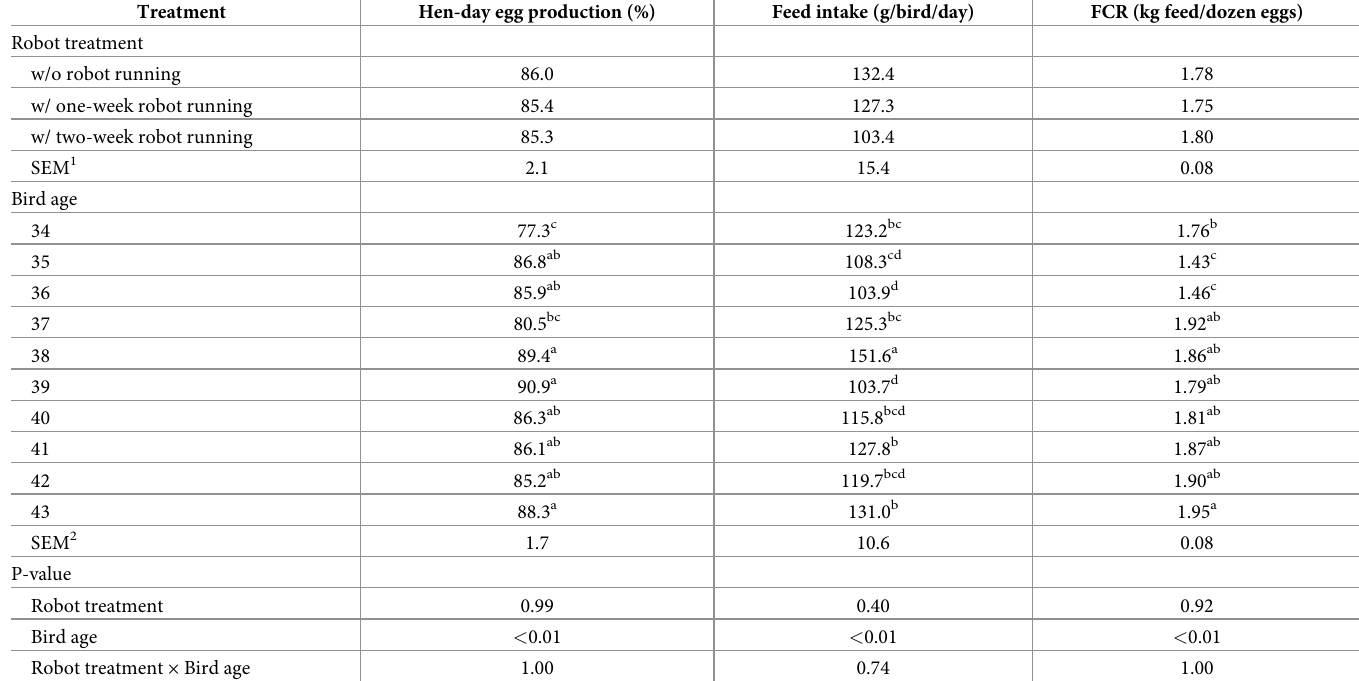
Table 2. Hen-day egg production, feed intake, and feed conversion ratio (FCR).